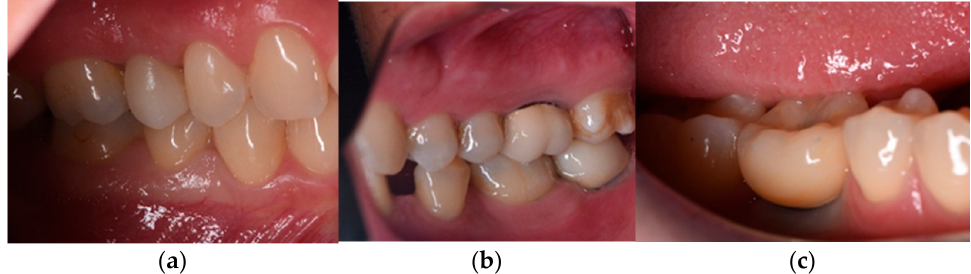
Figure 5. A esthetic indicator “Gingiva color around the restoration”—( а ) Group А —15. ( b ) Group B—47. ( c ) Group C—46. B—47. ( c ) Group